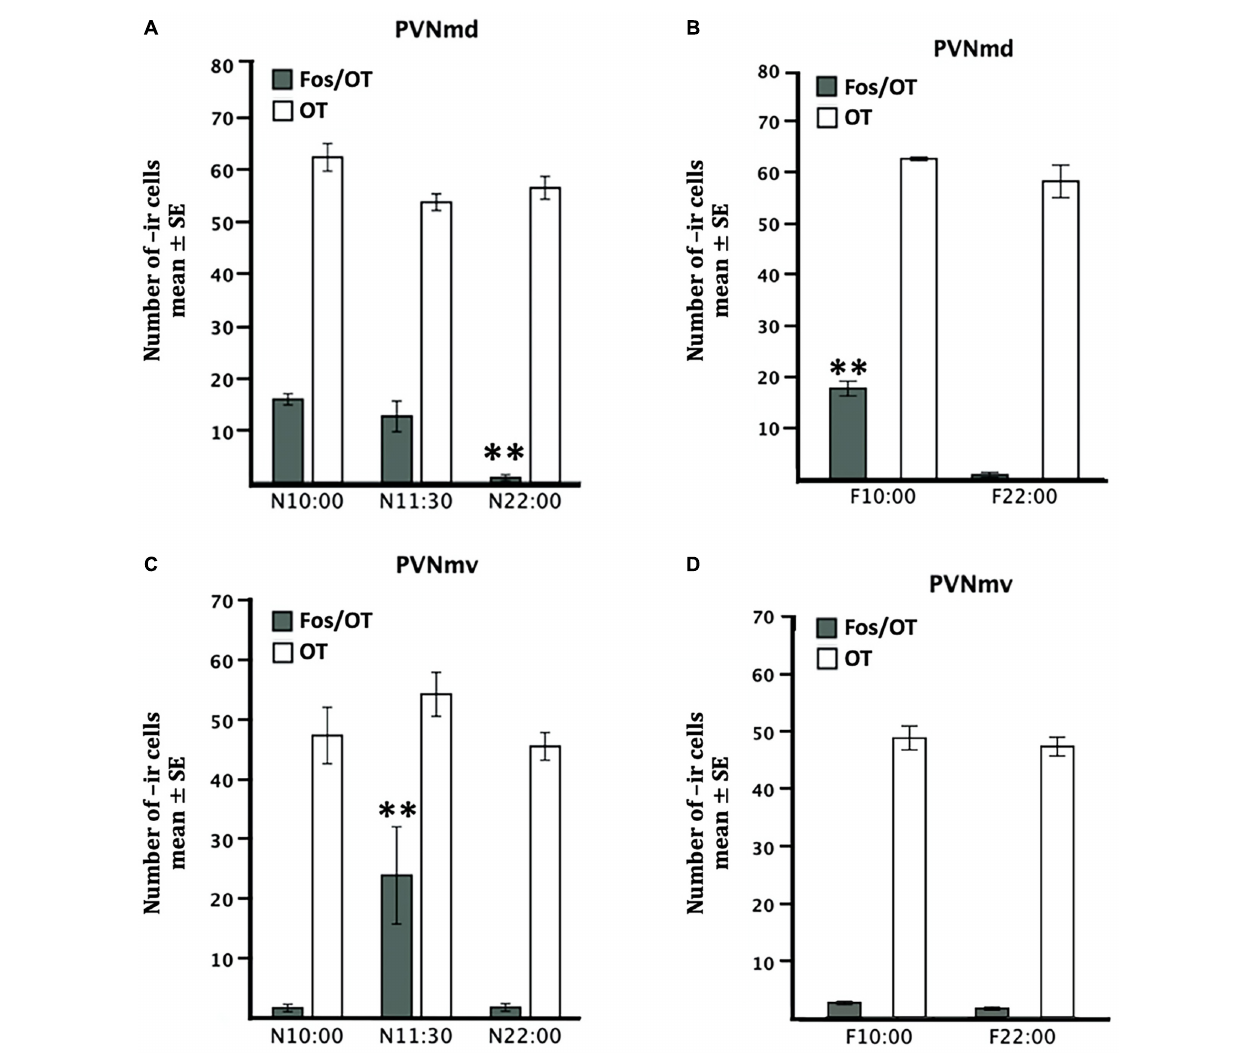
FIGURE 2 | Comparative distribution of OT- and Fos/OT-ir cells in PVNmd (A,B) and PVNmv (C,D) of pups nursed (A,C) and fasted for two nursing bouts (B,D) . Nursed pups were perfused just before nursing (10:00) or 1.5 and 12 h later. Fasted pups were perfused at the time of their previous scheduled time of nursing (10:00) or 12 h later. Values are mean ± SE. ∗∗ P < 0.01, denotes significant difference between highest and lower Fos-/OT-ir cells between different time